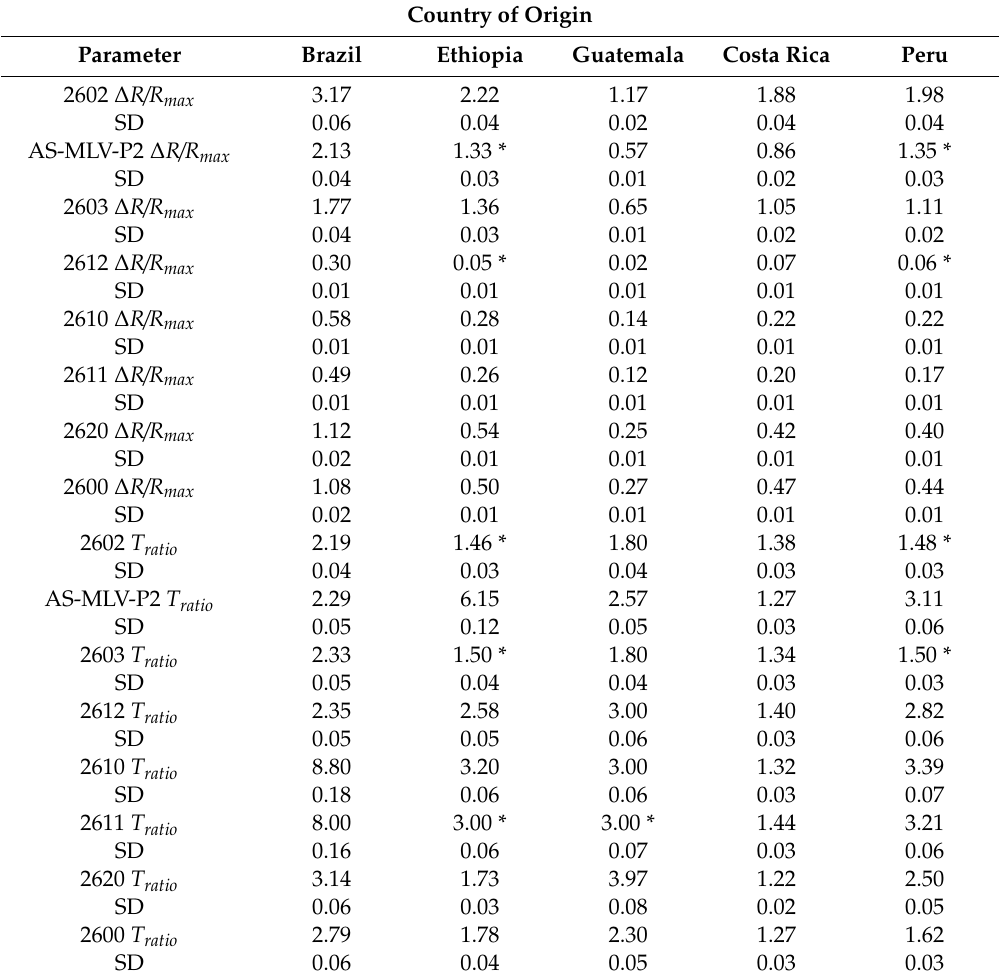
Table 2. The mean values of the obtained parameters using the Agrinose device and the results of the significance di ff erence analysis carried out using the Tukey